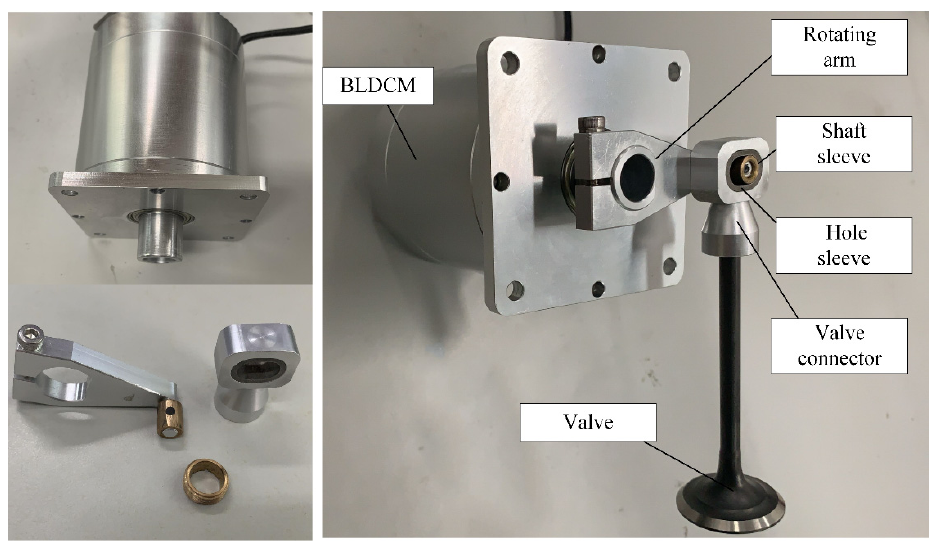
Figure 5. The main components of the actuator. Table 2. Main parameters of the actuator.